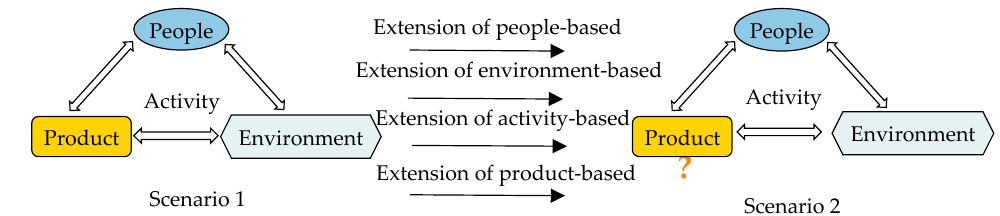
Figure 3. Scenario analysis model based on the divergence tree.